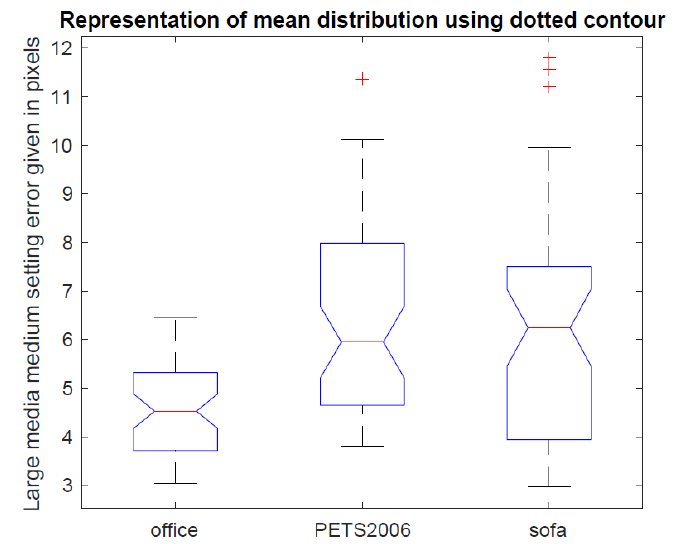
Figure 12. Mean fit error between the landmarks and the estimated contour in the office, PETS2006, and sofa scenes of CDnet2014